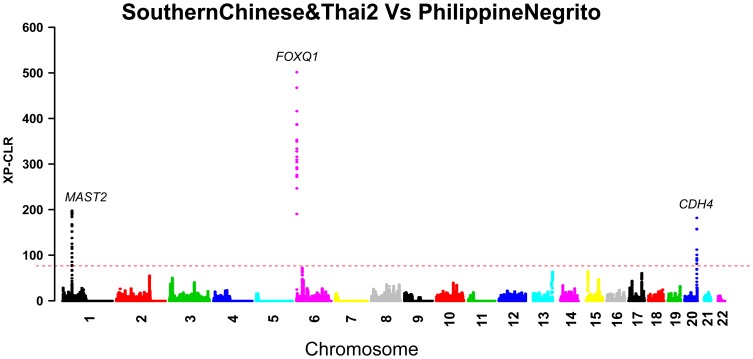
Signatures of FOXQ1, MAST2, and CDH4 in the comparison of SouthernChinese&Thai2 and Philippine Negritos.XP-CLR score was calculated as depicted in the Methods. Against the whole-genome distribution of XP-CLR score, the strongest signals were FOXQ1, CDH4 and MAST2 in the comparison between Philippine Negritos and SouthernChinese&Thai2. The horizontal line indicates a top 50 genome-wide cutoff level.